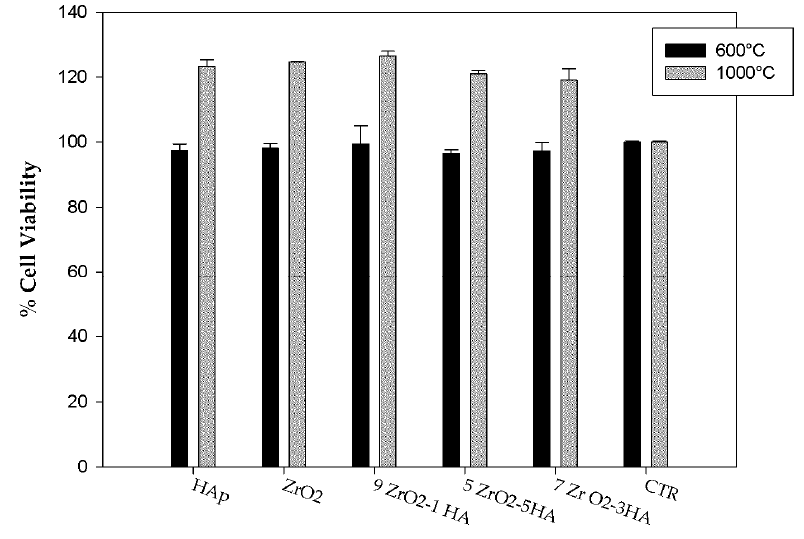
Figure 6. Cytotoxicity assay results. CTR: Control.